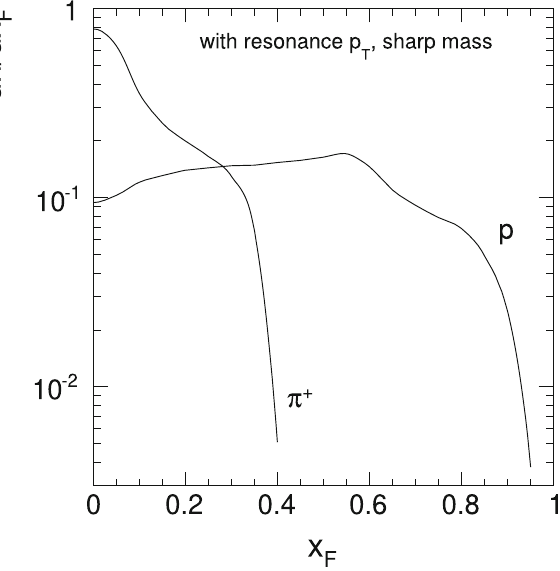
Fig. 154 dn / dx F for decay protons and pions as a function of x F